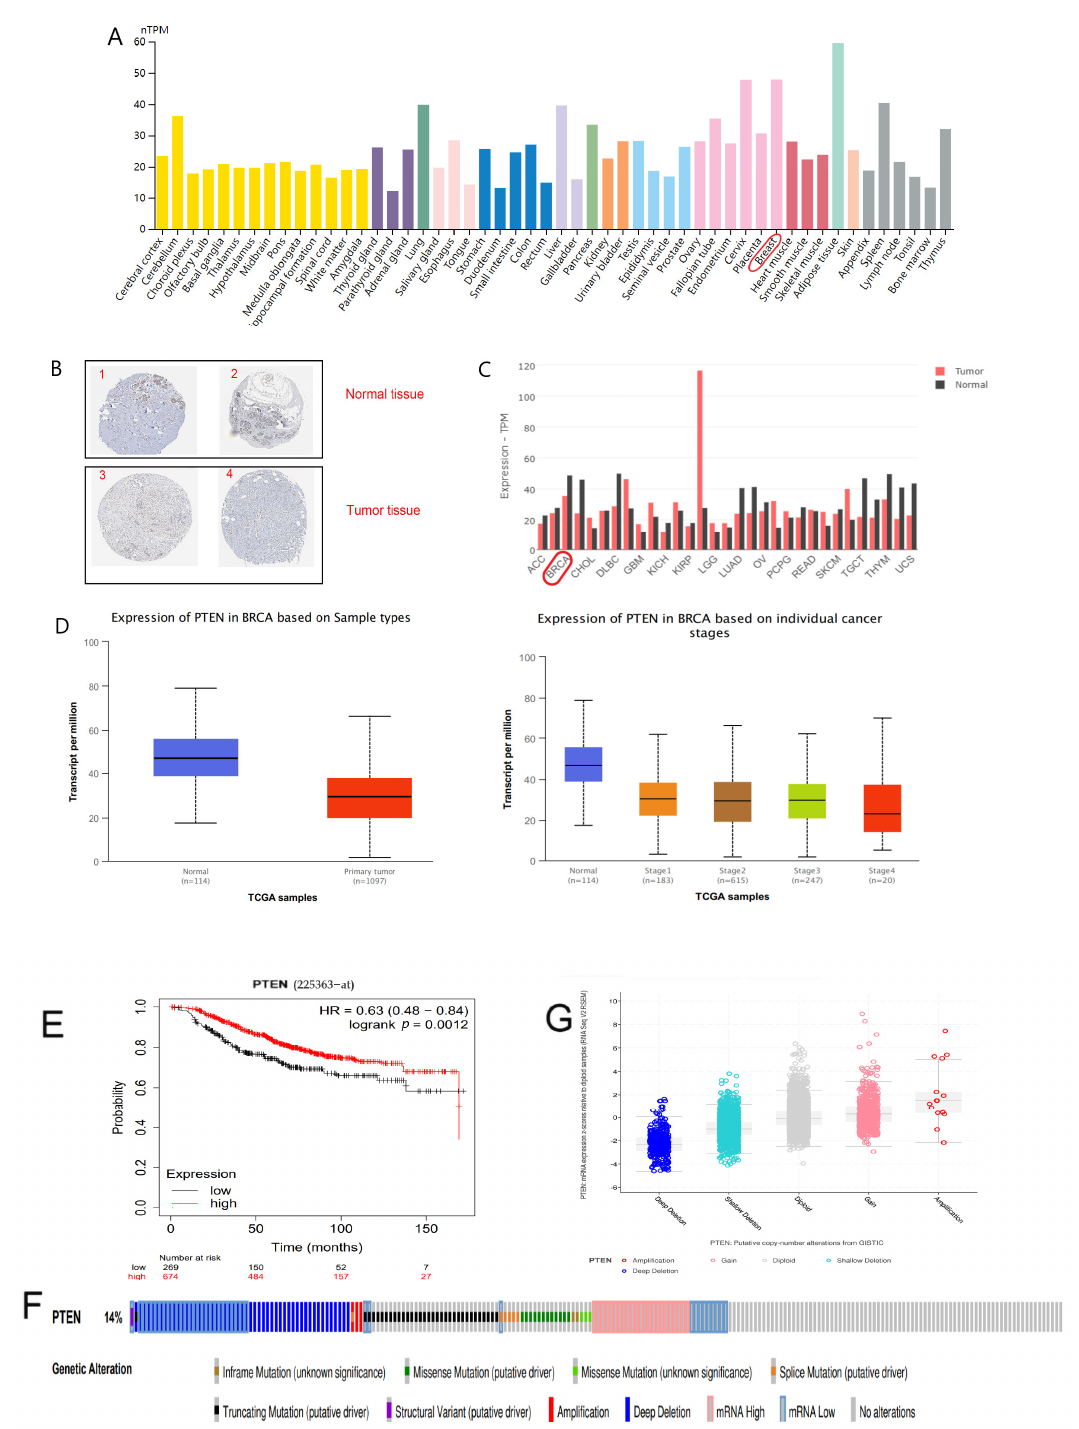
Figure 2. ( A ) Distribution of PTEN expression in pan-cancer tissues. ( B ) Results of immunohistochemical staining of PTEN in normal breast tissue and tumorous breast tissues as shown by HPA database. ( C ) Expression of PTEN in normal tissues and tumor tissues as revealed by GEPIA2. ( D ) Expression of PTEN in terms of BC samples and clinical stages as exhibited by UALCAN. ( E ) The KM survival curve of PTEN by Kaplan–Meier plotter. ( F ) The distribution of PTEN genomic alterations in TCGA BRCA presented on a OncoPrint plot. ( G ) The association between PTEN copy number and mRNA expression as shown in a dot plot generated by